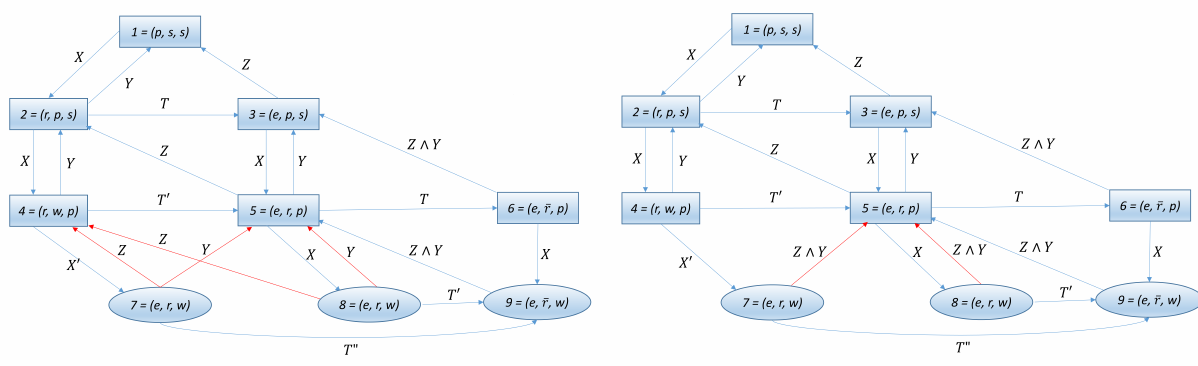
Figure 1. Transition diagrams for SRE ( left ) and MRE ( right ) models. The symbol ∧ denotes minimum; a red arrow denotes a failed system is